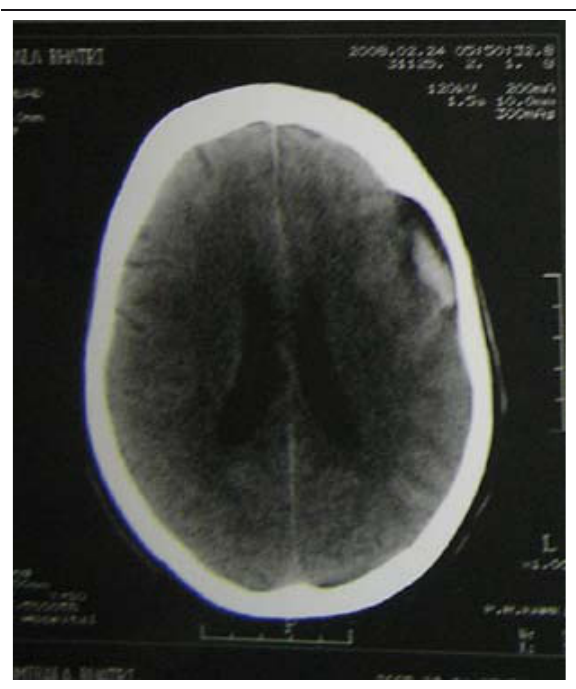
Figure 2. Repeat Ct scan showing bleed within the